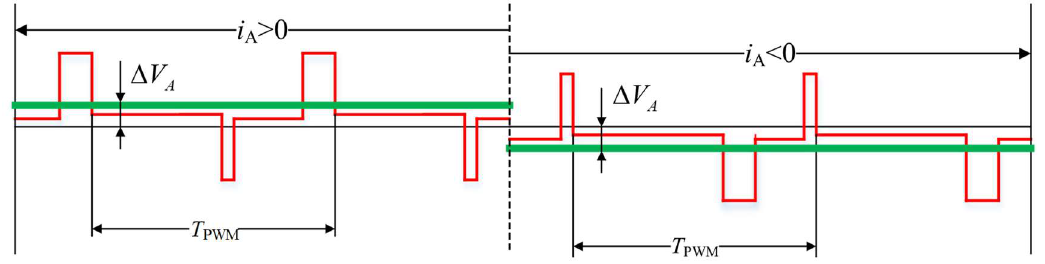
Figure 6. Waveform of average inverter output voltage error.